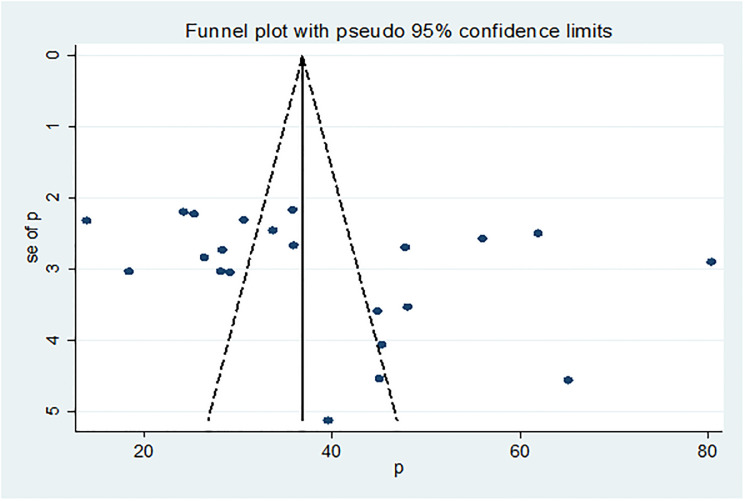
Funnel plots to test the publication bias of the included studies.